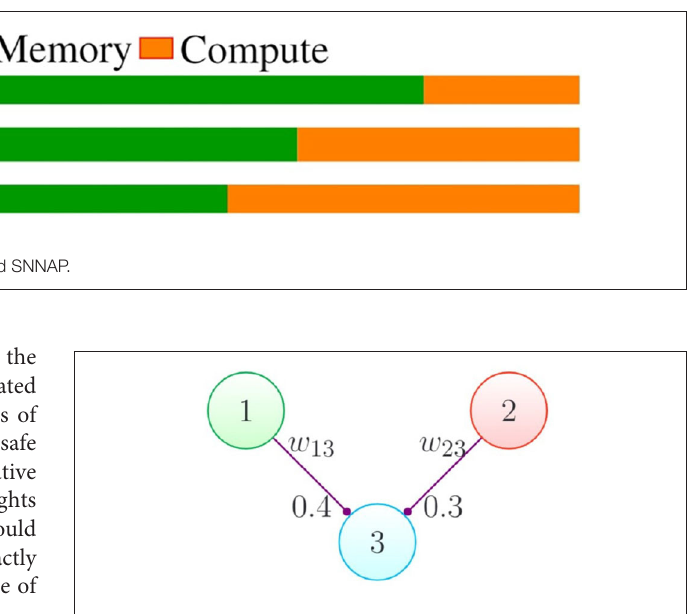
FIGURE 3 | Illustration: Neurons 1 and 2 sending spikes to